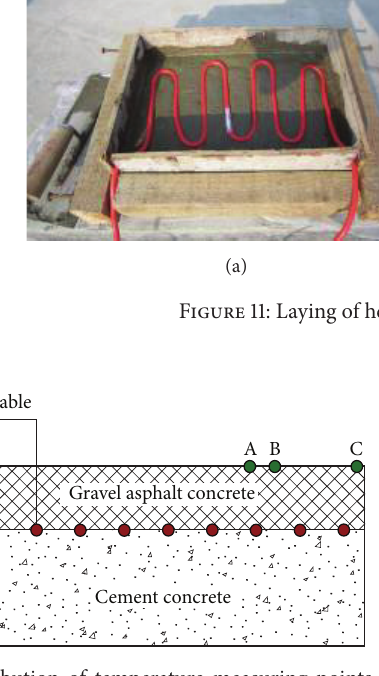
Figure 12: Distribution of temperature measuring points on the pavement.